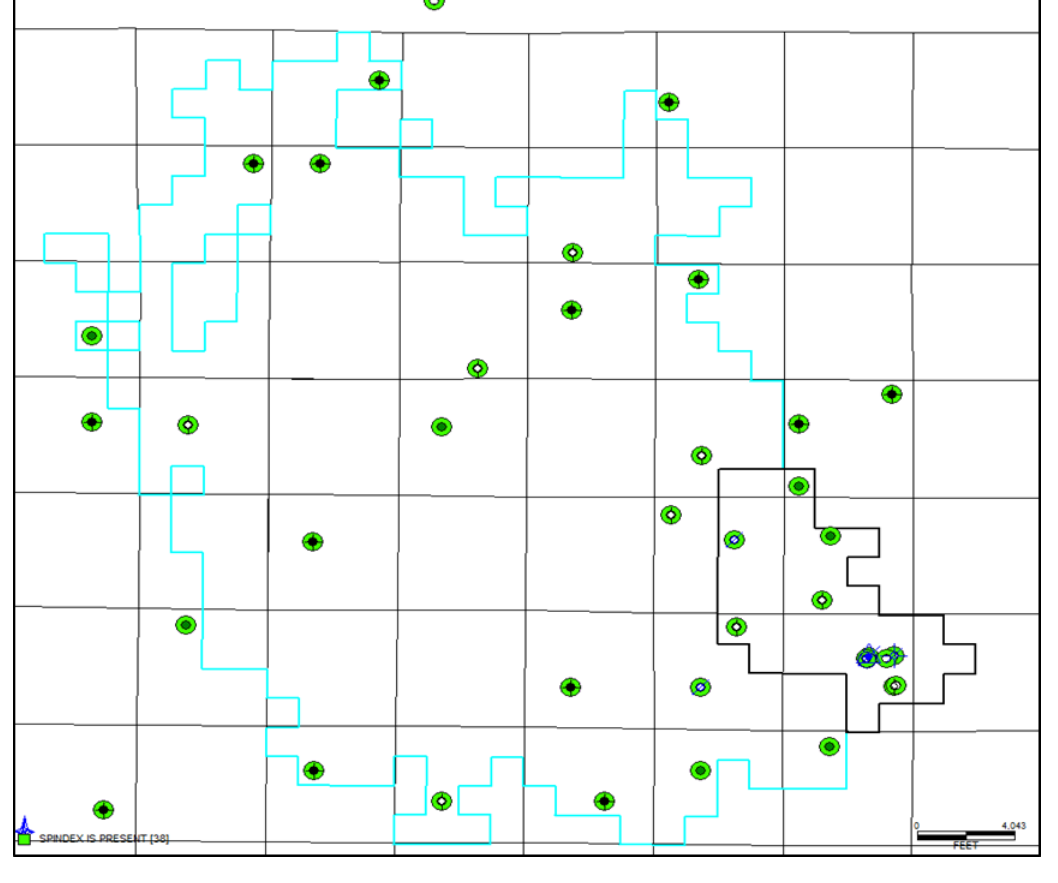
Figure 8. Locations of legacy oil wells within the Citronelle Oilfield used to generate synthetic porosity curves with the Artificial Neural Network. Green points indicate the location of each oil well used in this study. Map generated using Petra® .